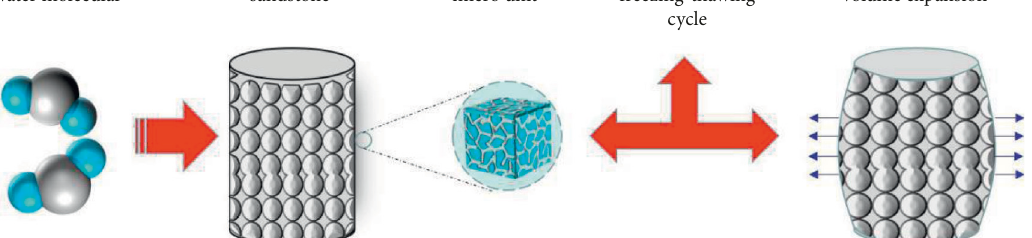
Figure 7: Mechanism of freezing and thawing